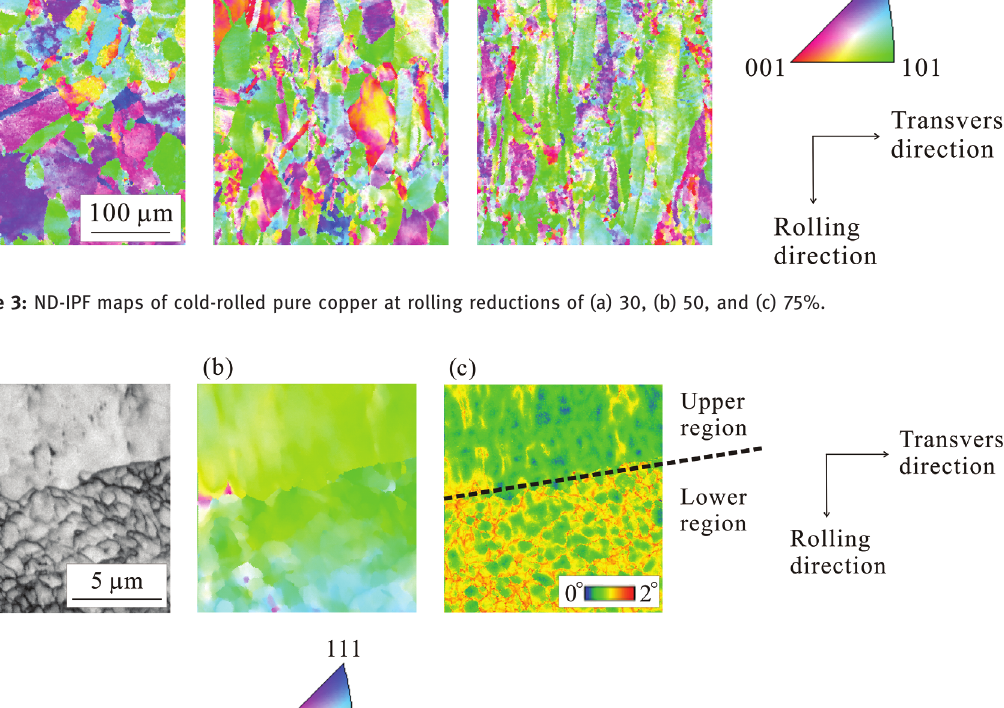
regions in Figure 4(c) were estimated to be (3.4 (cid:4) 1.5) (cid:5) 10 14 and (5.8 (cid:4) 2.3) (cid:5) 10 14 m − 2 , respectively.